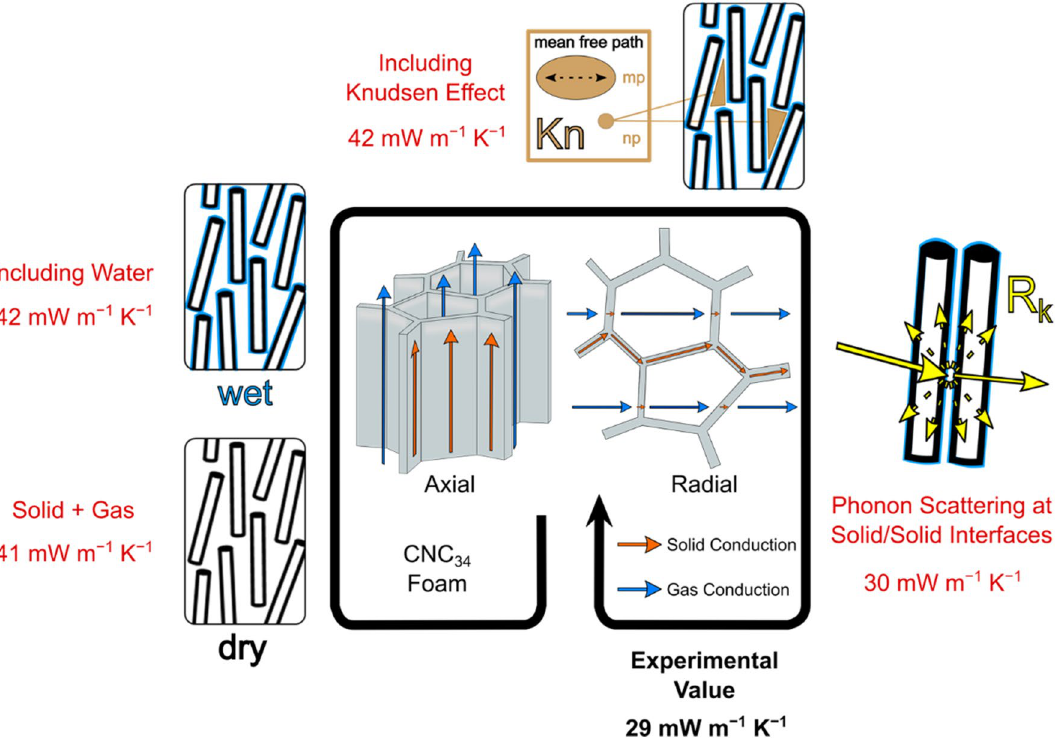
Figure 5. Summary of the assessed heat transfer modes in anisotropic CNC foams. Illustration of the morphological and structural features and the theoretical estimates (red numbers) based on the summation of the solid and gas contributions to the radial thermal conductivity of CNC 34 foams. The experimentally determined radial thermal conductivity is highlighted in black and